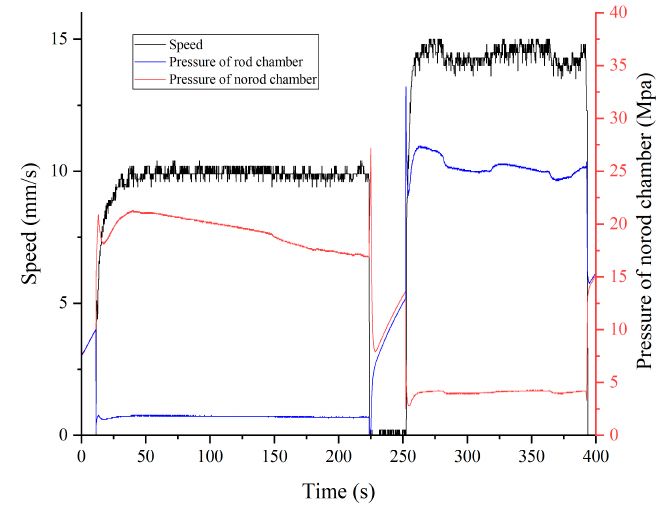
Figure 15. Step response experiment results of cylinder #1 using PID.